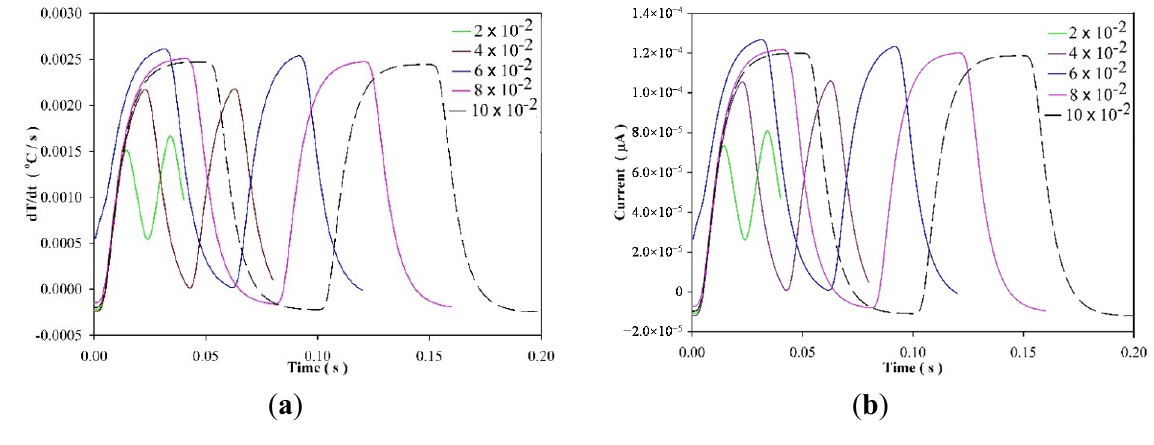
Figure 5. Relationships among the temperature variation rate ( a ); the current ( b ) and time at five periods of 2 × 10 − 2 s, 4 × 10 − 2 s, 6 × 10 − 2 s, 8 × 10 − 2 s and 10 × 10 − 2 s for the 200 μ m thick PZT cell